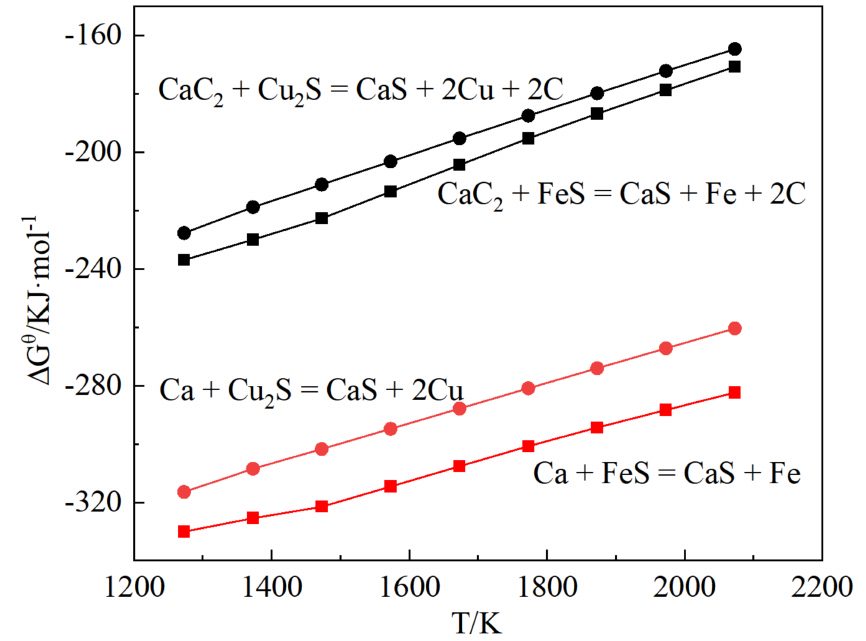
Figure 6. The Gibbs free energy of CaC 2 desulfurization